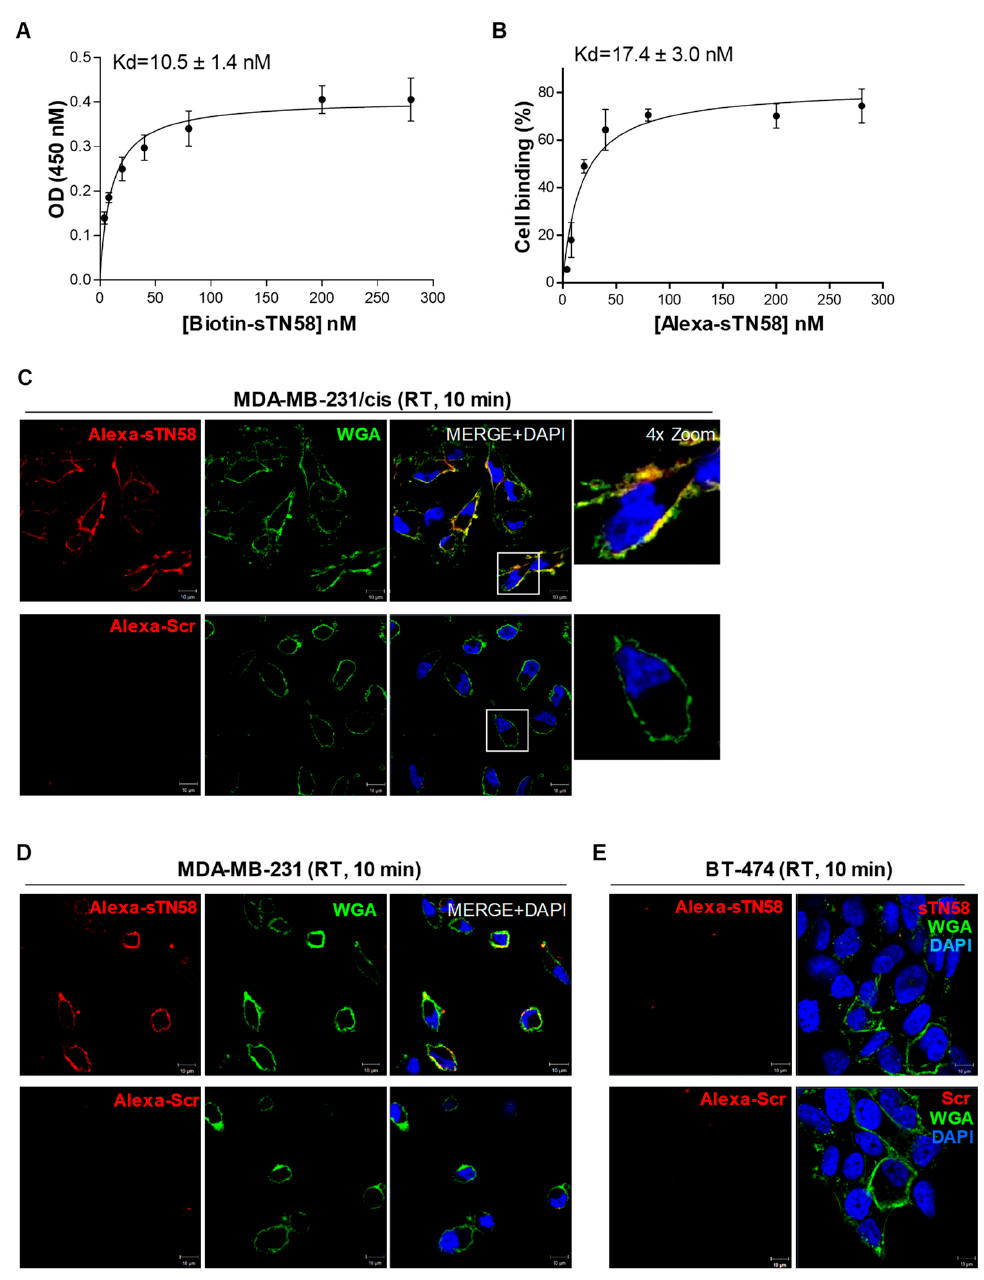
Figure 3. Cell binding of sTN58 aptamer. Binding curves of sTN58, 5 ′ -biotinylated ( A ) or Alexa 647-labeled ( B ) on MDA-MB-231/cis cells for the calculation of the apparent Kd of aptamer-cell interaction. Binding was analyzed using streptavidin-biotin-based ( A ) or flow cytometric ( B ) assays. Data shown are mean ± SD of four independent experiments. ( C – E ) Representative confocal images of MDA-MB-231/cis ( C ), MDA-MB-231 ( D ) and BT-474 ( E ) cells incubated for 10 min at RT with Alexa 647-labeled sTN58 or Scr. Alexa 647-labeled aptamer, WGA-488, and nuclei are visualized in red, green, and blue, respectively. All digital images were captured at the same setting to allow direct comparison of staining patterns. Magnification 63×, 1.0× digital zoom, scale bar = 10 μ m. At least three independent experiments were performed. In ( C , D ), co-localization results appear yellow in the merged images. Inset: 4× digital zoom.